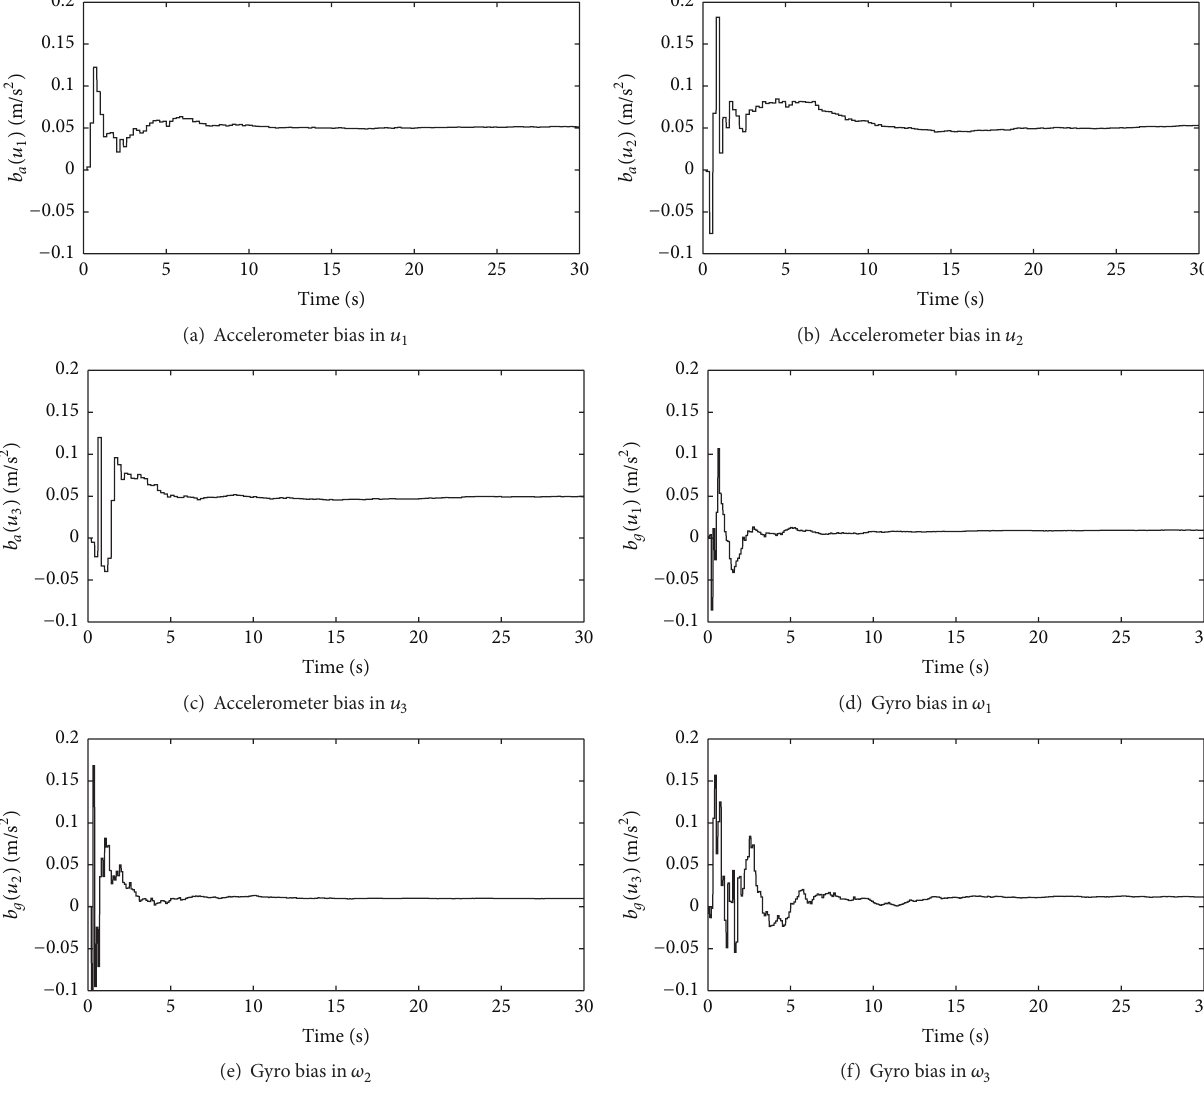
Figure 3: Estimated accelerometer and gyro